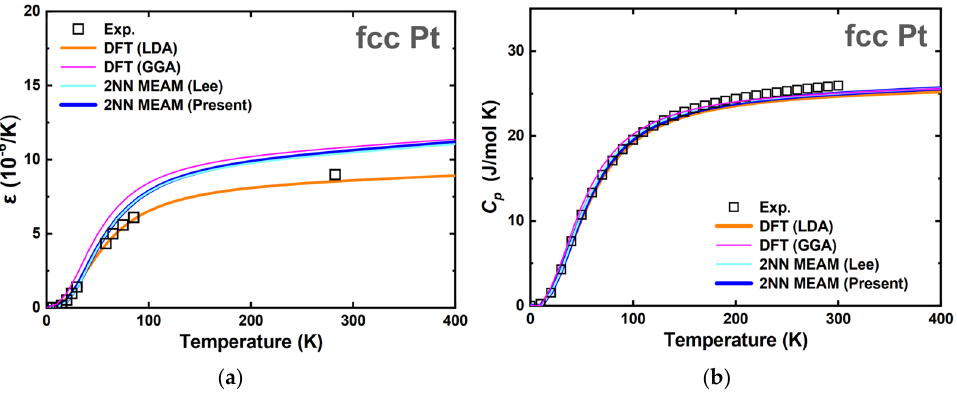
Figure 3. Thermal properties ( a ) thermal expansion coefficient ( 𝜀 ) and ( b ) heat capacity ( 𝐶 (cid:3017) ) of fcc Pt predicted based on the quasiharmonic (QH) approximation. The curves obtained from the experiment [89,90], the present DFT calculation (LDA and GGA), and the present and previous [69] 2NN MEAM potentials are compared.